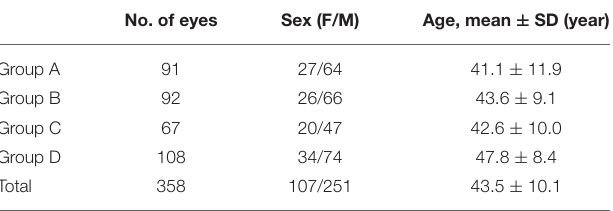
TABLE 1 | Demographic information of patients in groups A, B, C and D.